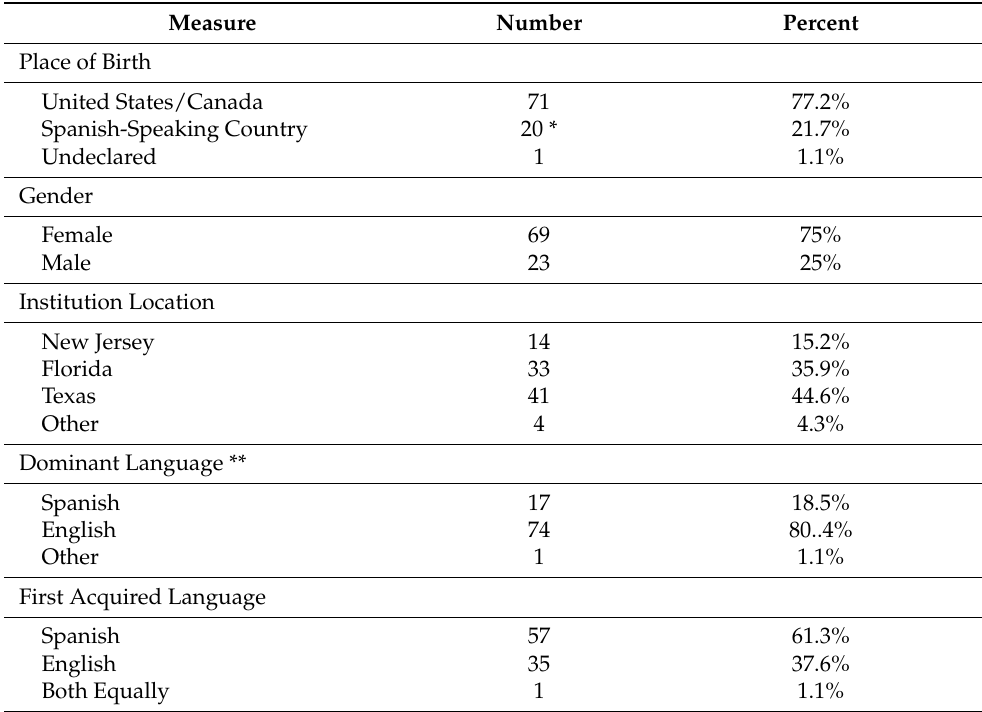
Table 1. Descriptive statistics of the